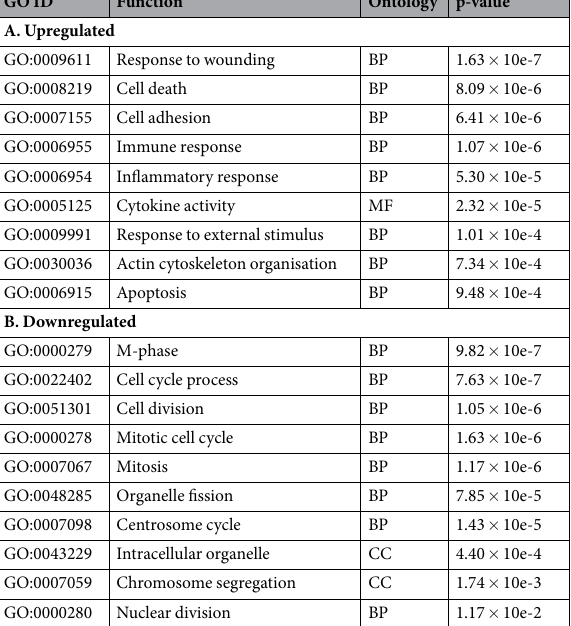
Table 1. Gene ontology (GO) term annotation for the list of differentially expressed genes. (A) List of gene ontology terms associated with up-regulated genes. (B) List of gene ontology terms associated with down- regulated genes. BP = biological process, MF = molecular function and CC = cellular component. P-values represent the significance of functional association as calculated by